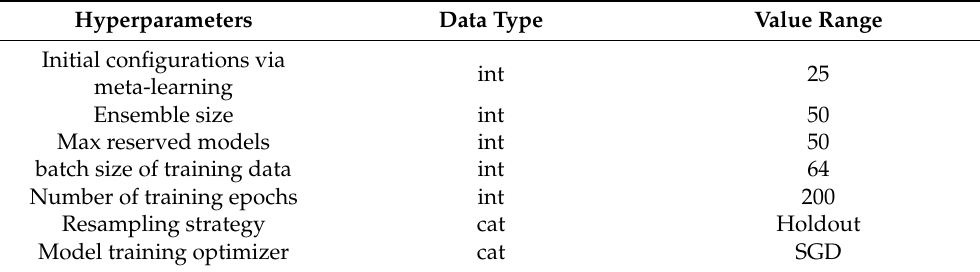
Table 3. Hyperparameters used in verification.